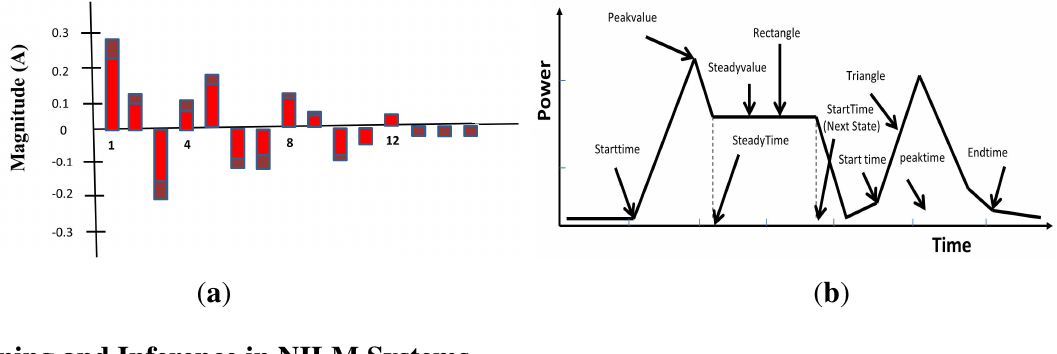
( a ) Harmonic signature of monitor where black bars show fluctuations, (From [17]); ( b ) Schematic diagram of two unit graph, (From